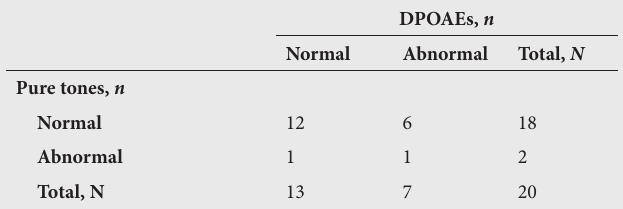
Table 7. Cross classifi cation of pure tone thresholds and DPOAEs for stage fi ve participants for 8 000 Hz/